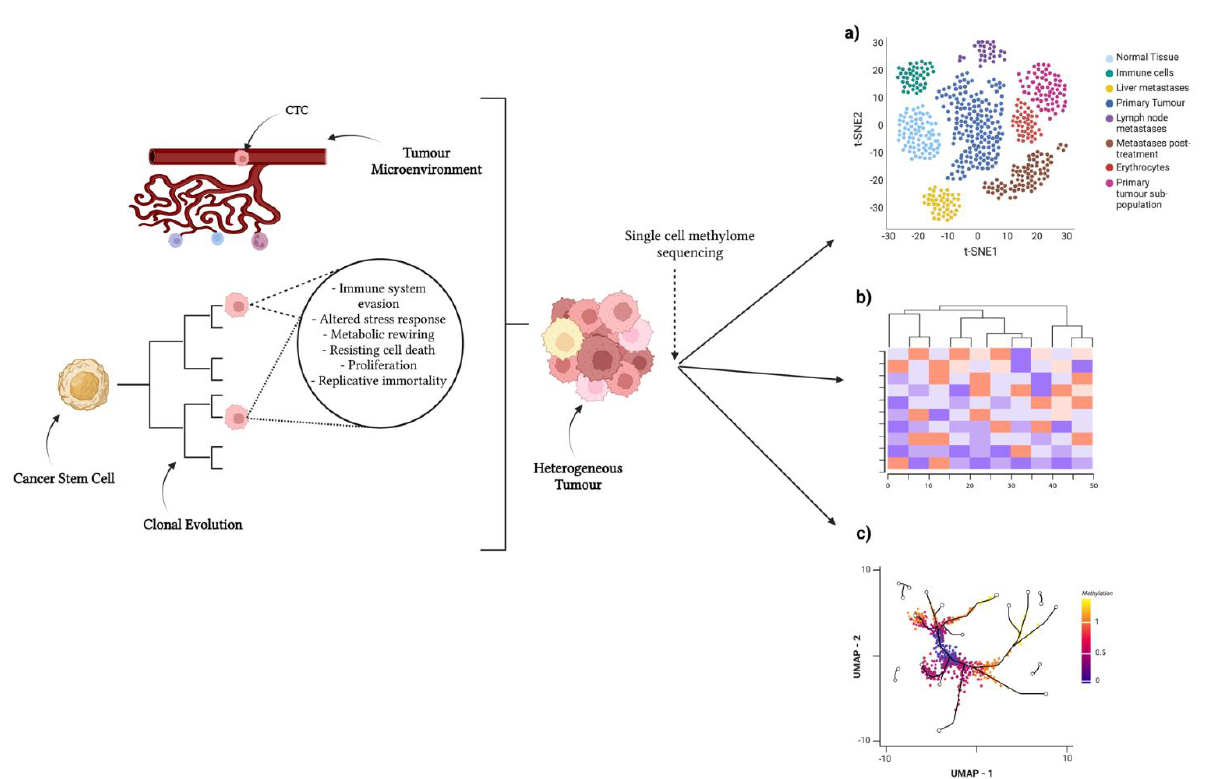
Figure 1. Single-cell approaches to identify heterogeneity in tumour population. Tumour-initiating stem cells develop in tissue of origin. These undergo branched tumour evolution, acquiring random mutations and epigenomic alterations. The tumour microenvironment influences heterogeneity via physical and chemical signals. A combinatorial effect of these concepts induces a highly heteroge- neous tumour, as well as circulating tumour cells (CTCs) disseminating from said tumour. Single-cell methylome sequencing of tumours can provide insight into subpopulations/differing cell states by clustering cells: ( a ) clustering via t-SNE, ( b ) clustering via UMAP, and ( c ) cell lineages/differentially methylated regions via heatmaps. Created with https://biorender.com/ (accessed on 13 De- cember 2022).